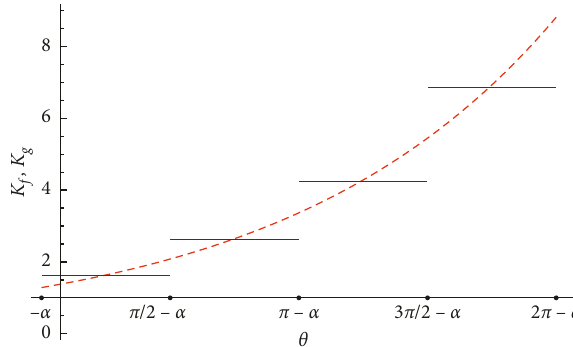
Figure 10: Curvatures of the Fibonacci spiral (solid line) and golden spiral (dashed line).